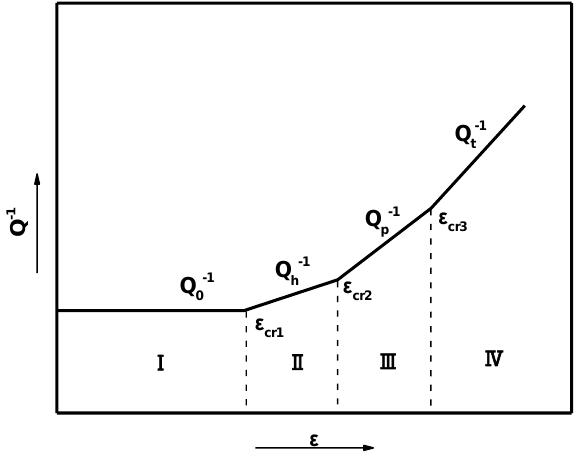
Figure 6. The relationship of damping and strain amplitude.